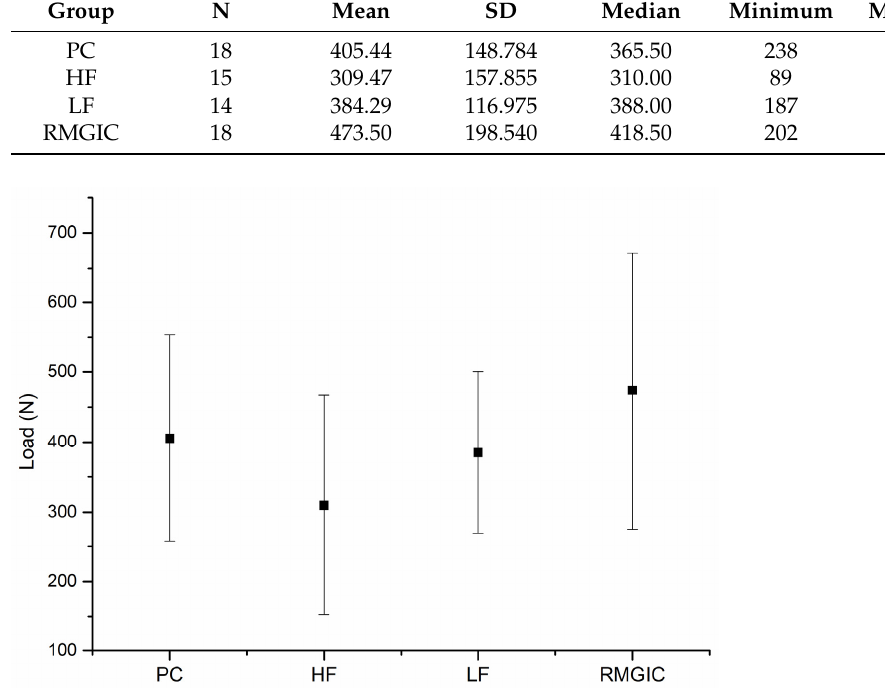
Figure 4. The mean values for the fracture loads (Newton) and standard deviation of the restored teeth.